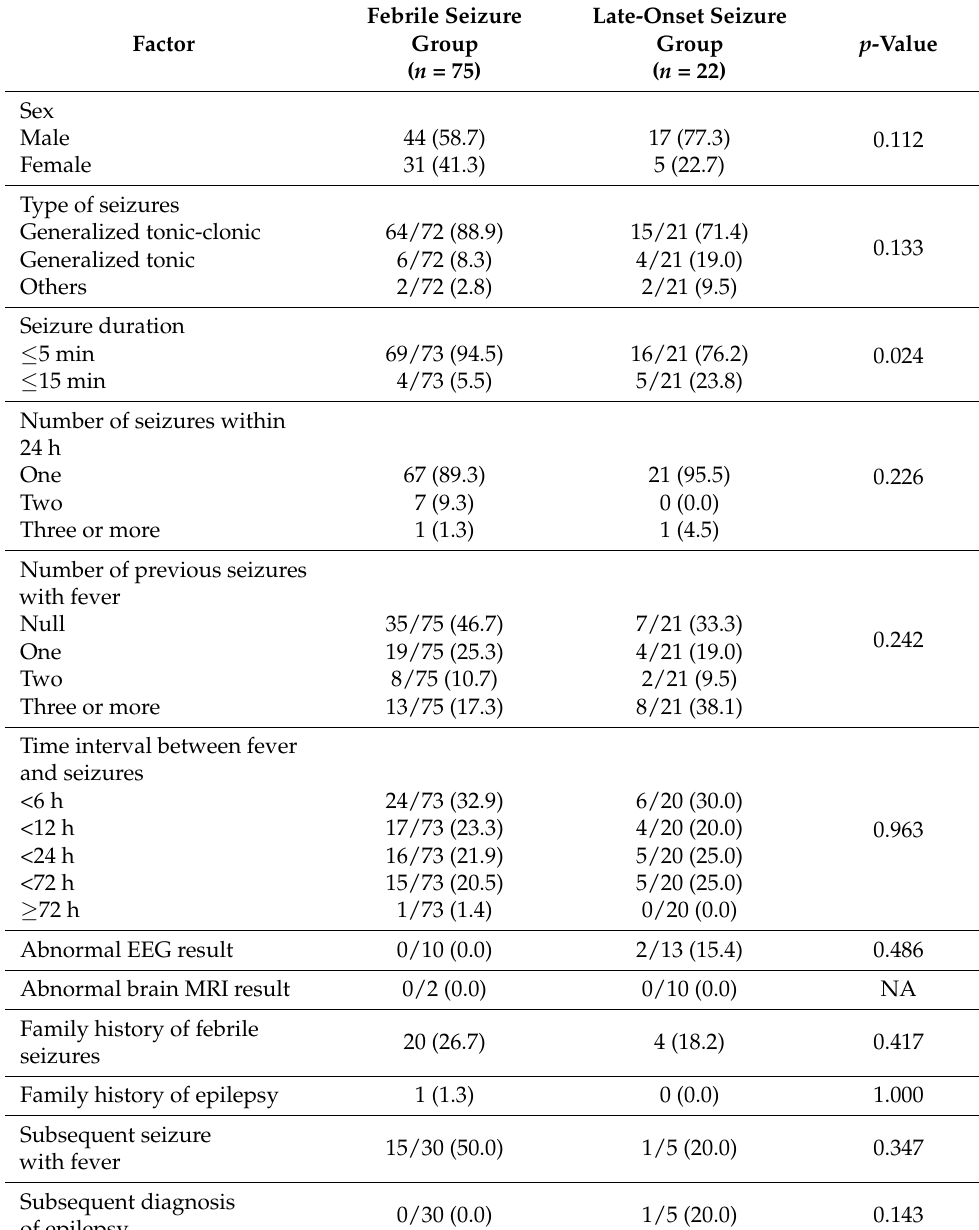
Table 2. Comparison between the febrile seizure and late-onset seizure groups in the influenza